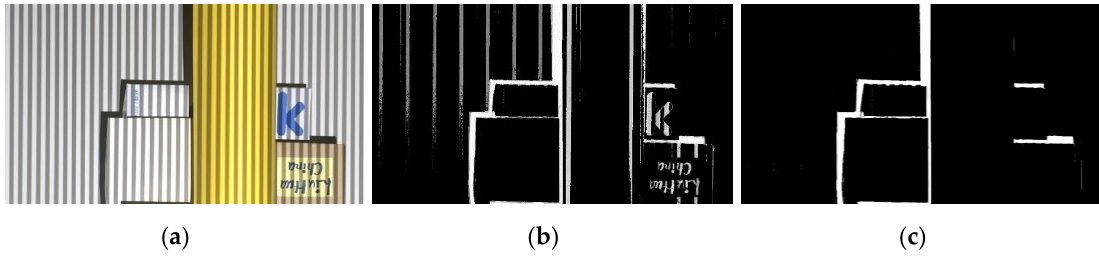
Figure 9. Feature vector used to identify shadow regions.